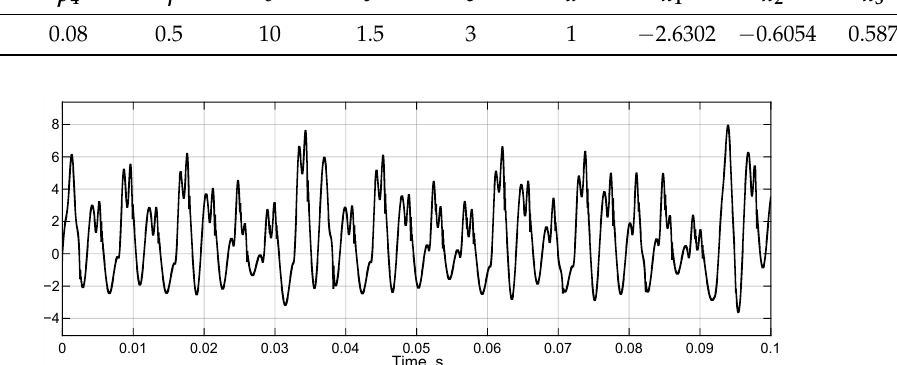
Figure 1. Master chaos generator’s output signal R out .